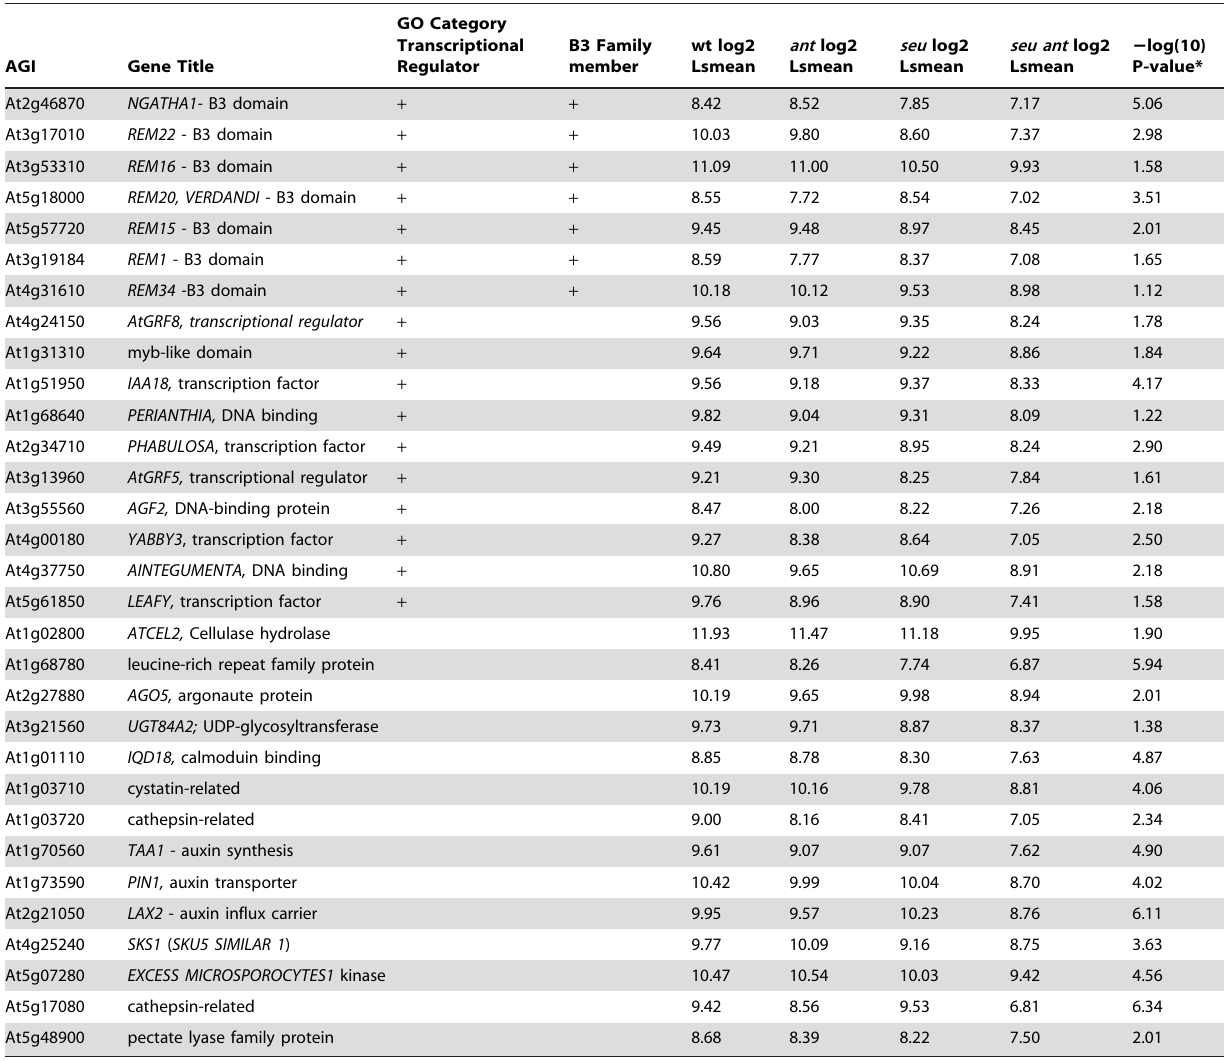
Table 1. Approach II Candidate Genes.